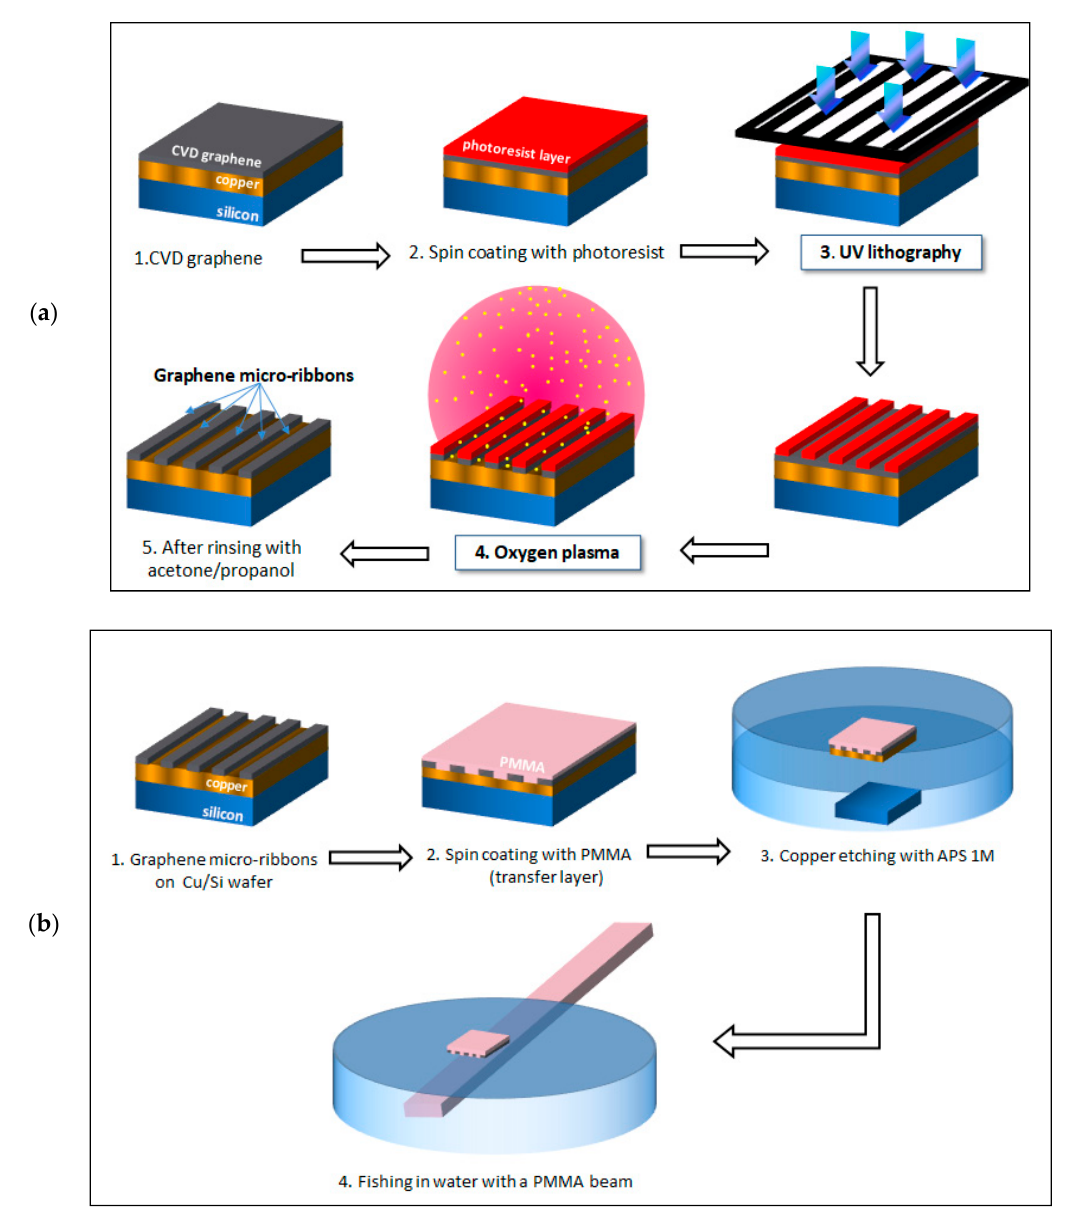
Figure 1. Micro-patterning of CVD graphene micro-ribbons ( a ) and transfer onto polymeric matrix ( b